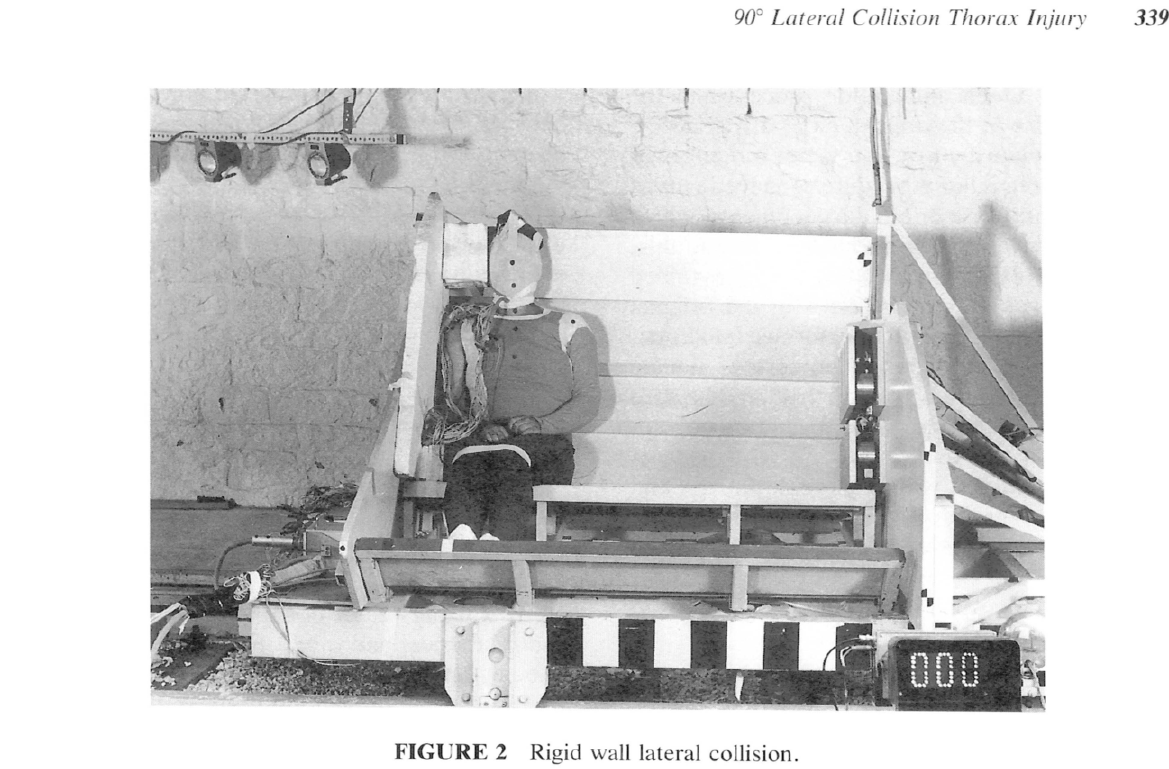
FIGURE 2 Rigid wall lateral